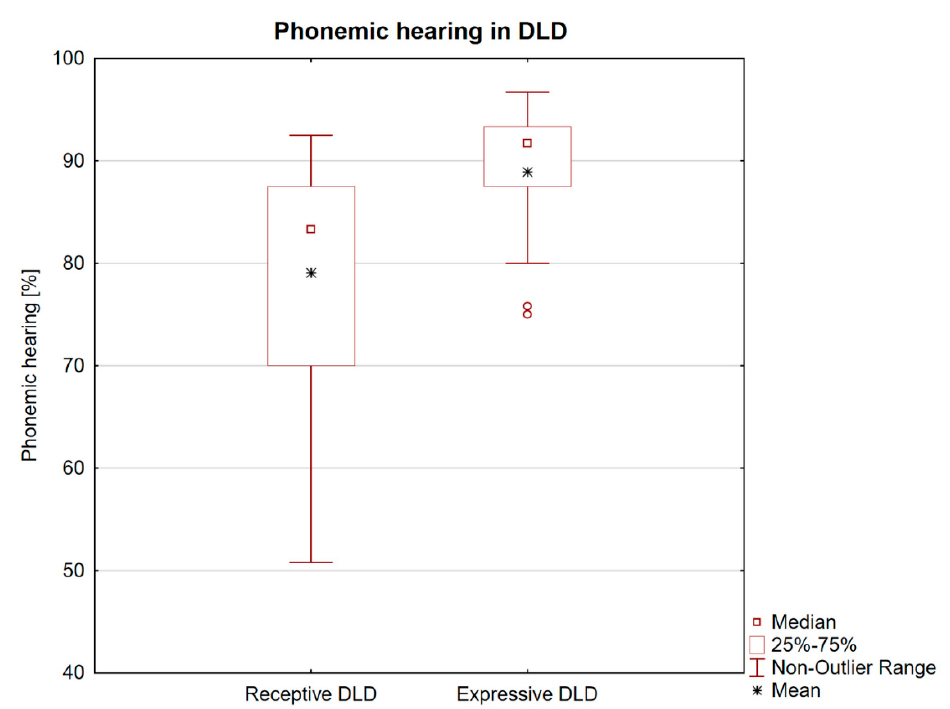
Figure 1. Comparison of phonemic hearing (Czech test of auditory discrimination) in developmental language disorder subtypes (receptive and expressive). The box plot shows that children with the receptive form showed a significantly increased number of phonemic discrimination errors. Two expressive DLD children represent outlying values.